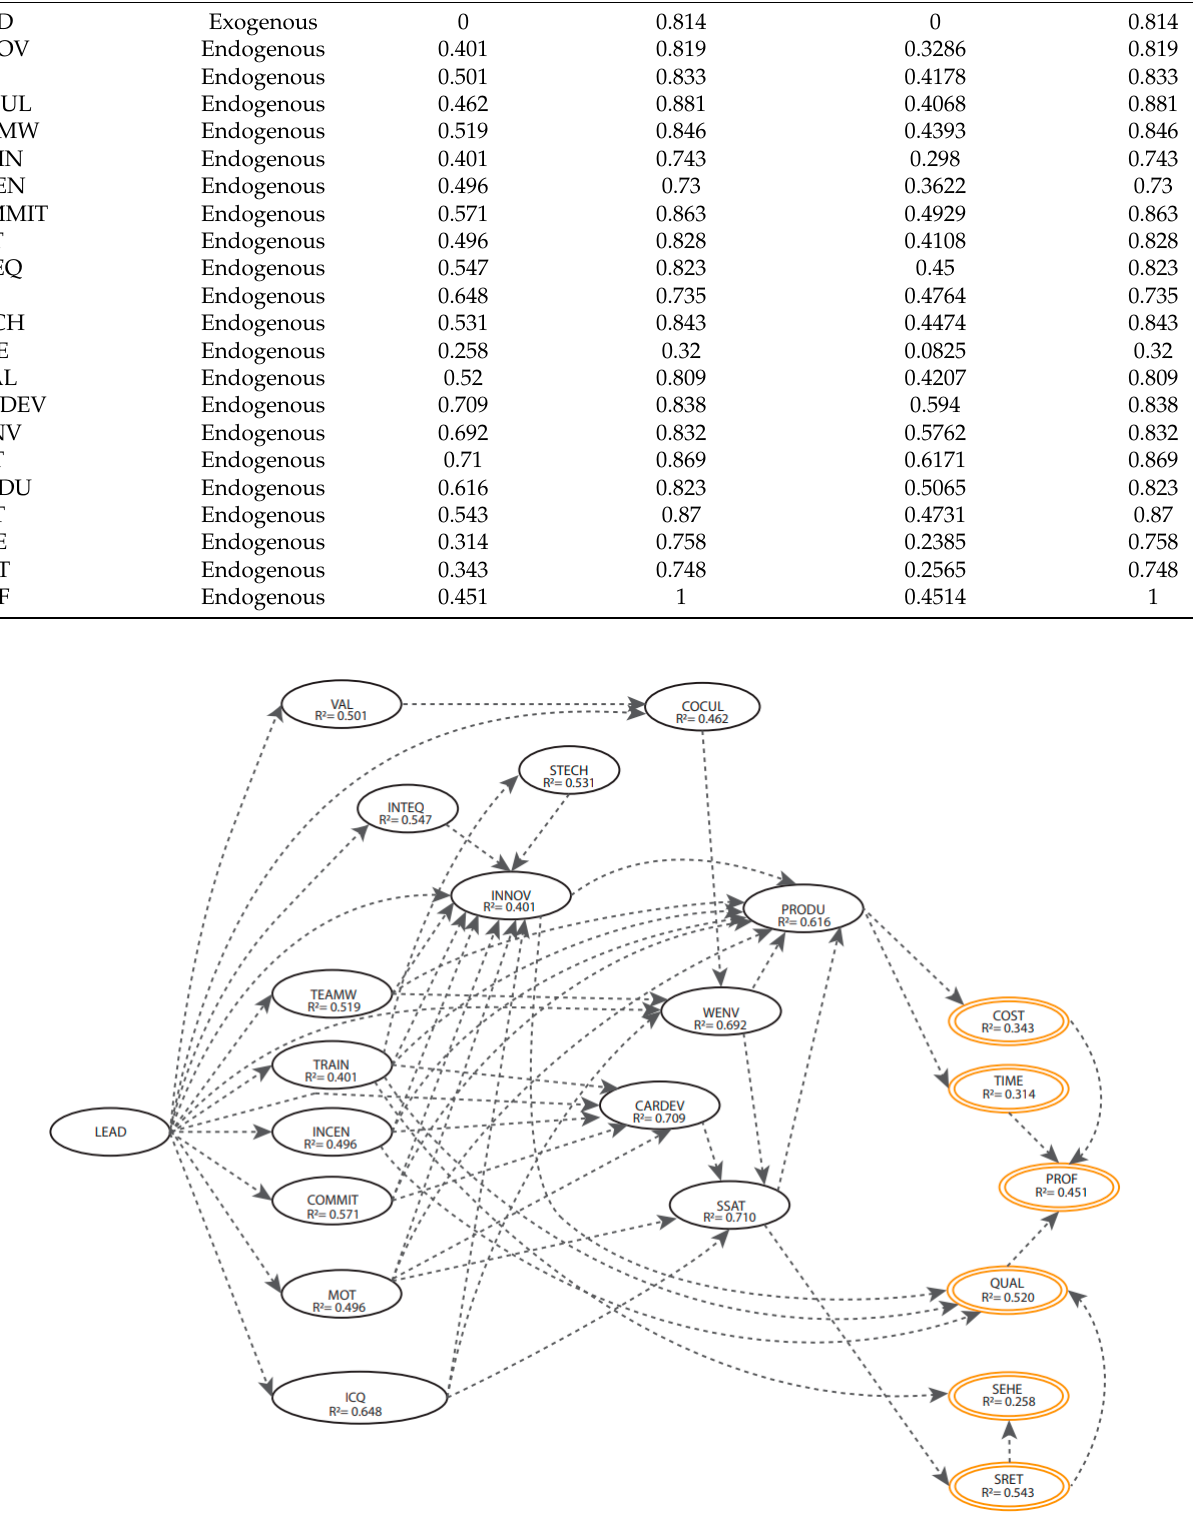
Figure 4. 𝑅 (cid:2870) for Human resources Figure 4. R 2 for Human AVE is a measure used to assess the degree to which a set of indicators (or items) measures a latent construct. According to Fornell and Larcker [106] and Duarte and Raposo [107], the recommended cuto ff for AVE is 0.50 or higher, which indicates that more than 50% of the variance of the construct is explained by its indicators. In other words, the AVE value represents the average amount of variance that each indicator shares with the other indicators in the same construct. However, it is important to note that AVE can only be applied to externally directed blocks, which means that the indicators should be related based on a theoretical rationale. If the indicators are not related to each other, AVE cannot be computed. In the context of Table 6, all the variables meet the AVE evaluation criteria except for the SEHE variable, which does not meet the cuto ff of 0.50. This may indicate that the indicators of the SEHE variable are not strongly related to each other, or that they may not be measuring the same latent construct. Further analysis and interpretation are needed to understand the reasons behind the low AVE value of the SEHE variable. In a PLS analysis, adequate discriminant validity is established when a latent variable shares more variance with its measurements or indicators than with another latent variable in a determined model [104]. To assess the discriminate validity, the use of the average variance extracted (AVE) is recommended, that is, the mean variance shared between a construct and its measures [106,108]. This measurement should be greater than the variance shared between the construct with the model’s other constructs (the squared correlation between two constructs). As an acceptable indicator, the AVE must be greater